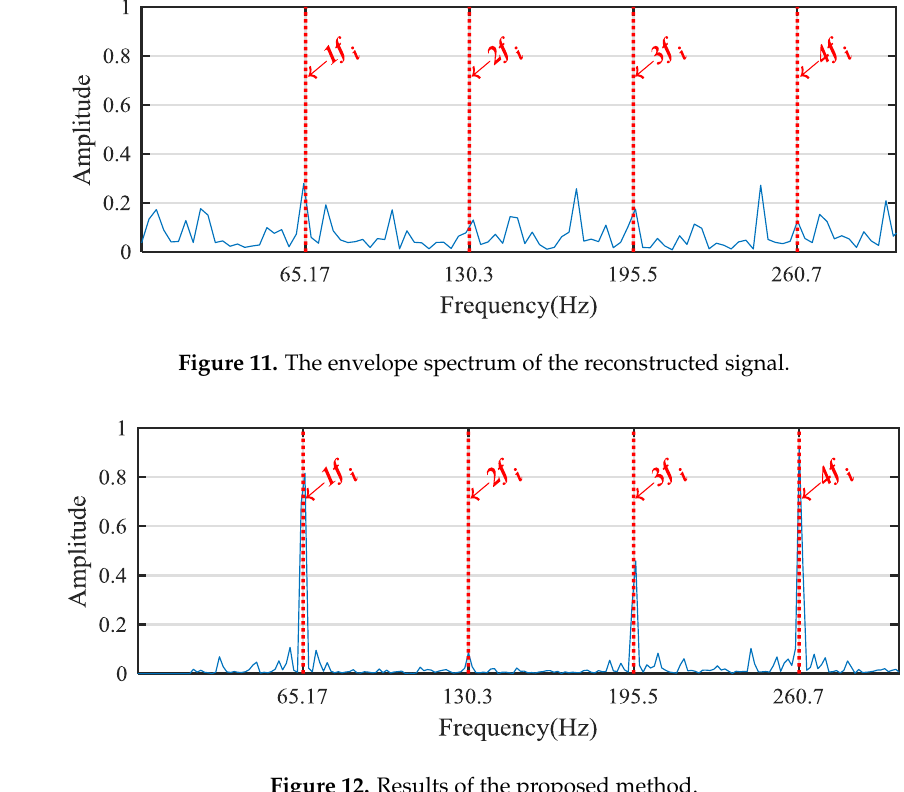
Figure 10. Energy distribution proportional histogram of the faulty bearing.